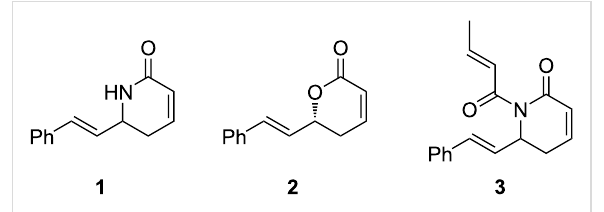
Figure 1: Aza-goniothalamin 1 , ( R )-(+)-goniothalamin 2 and acylated aza-goniothalamin analogue 3 [14-18].